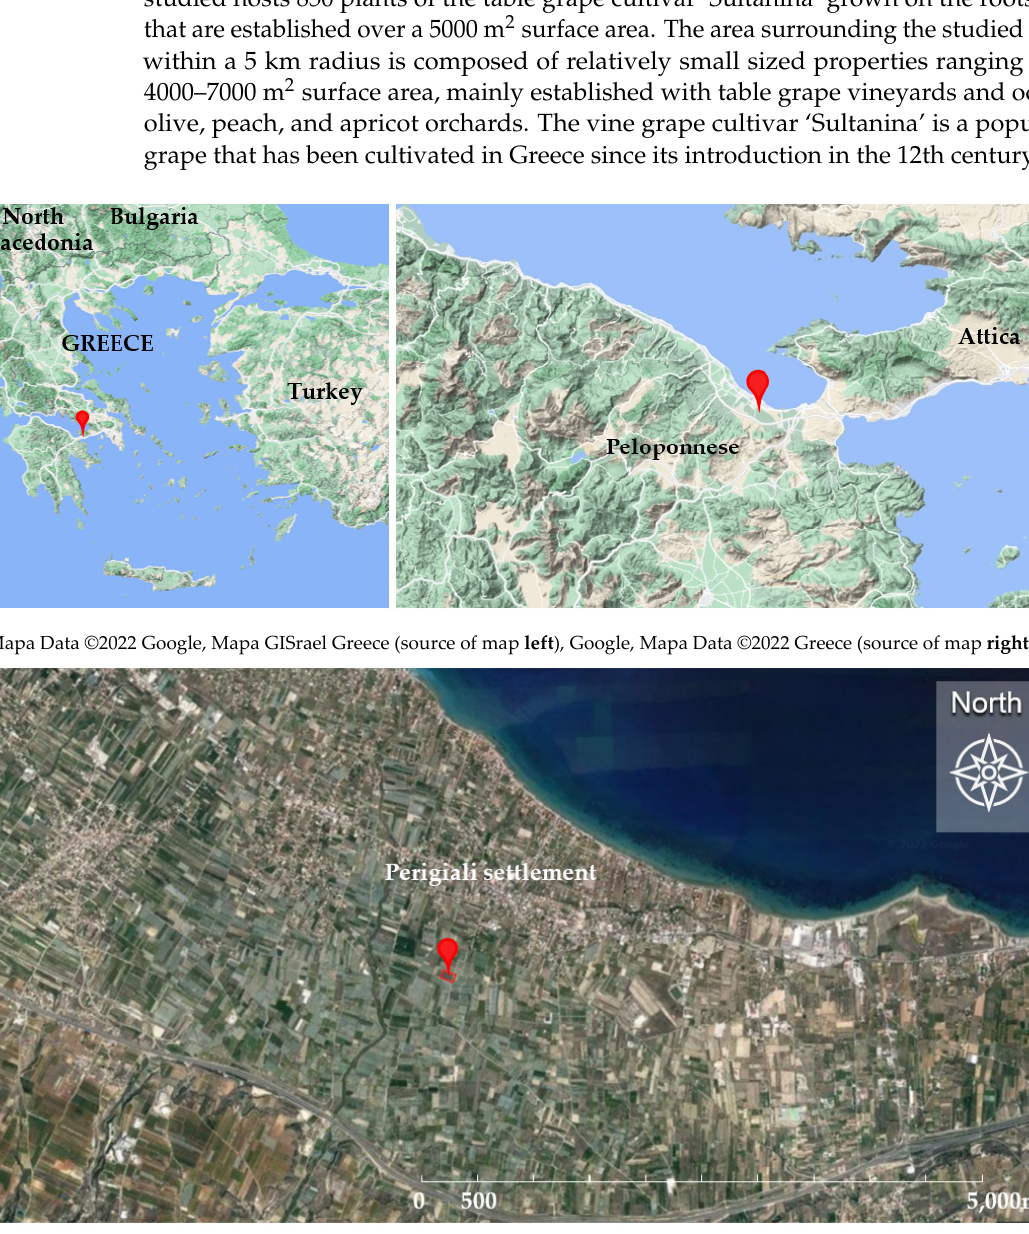
Figure 1. Site location of the studied ‘Sultanina’ vineyard at Perigiali, Korinthia, Greece, indicated with the red colored pin.